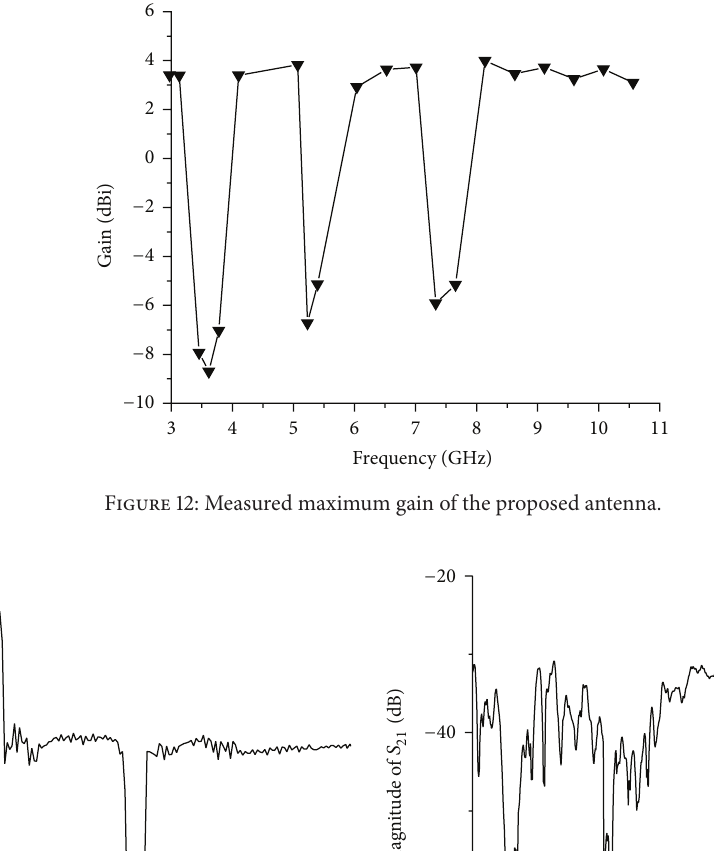
possible for the proposed antenna to communicate with good UWB pulse preserving